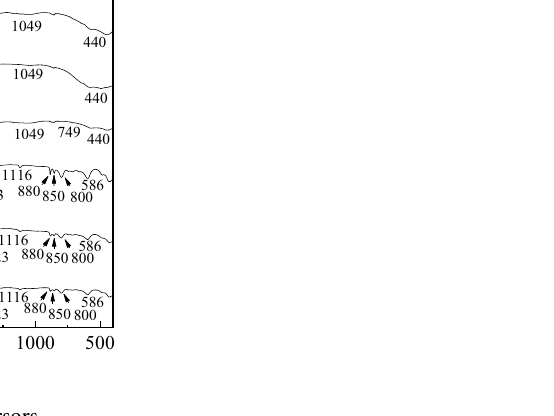
Figure 4. FTIR spectra of the dried